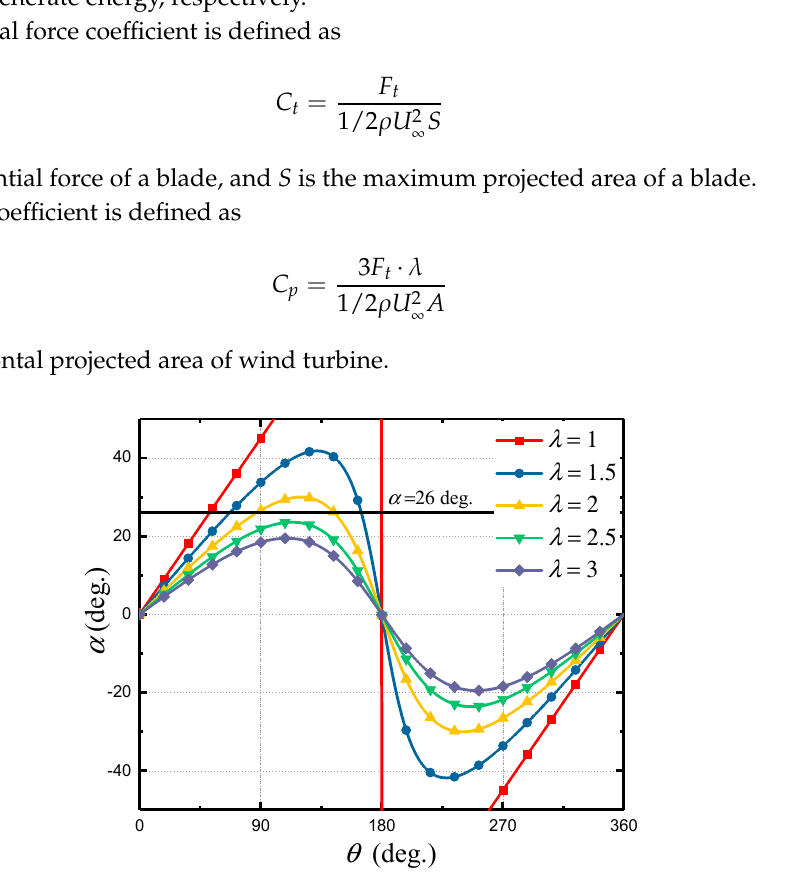
Figure 10. Angle of attack with azimuth.